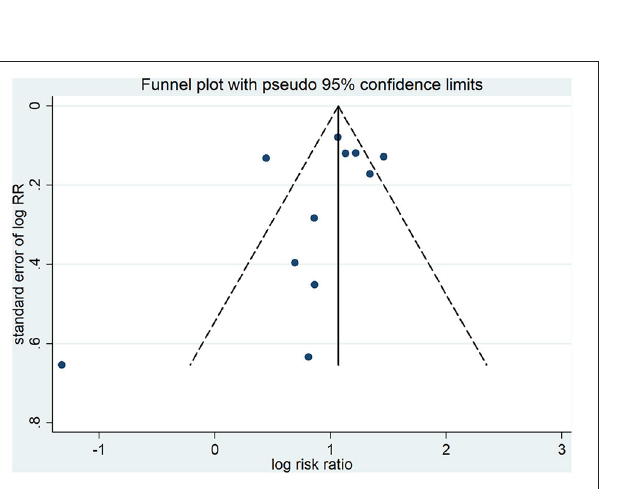
FIGURE 4 | Forest plot of the effect of anticoagulants on bleeding events in hospitalized COVID-19 patients.